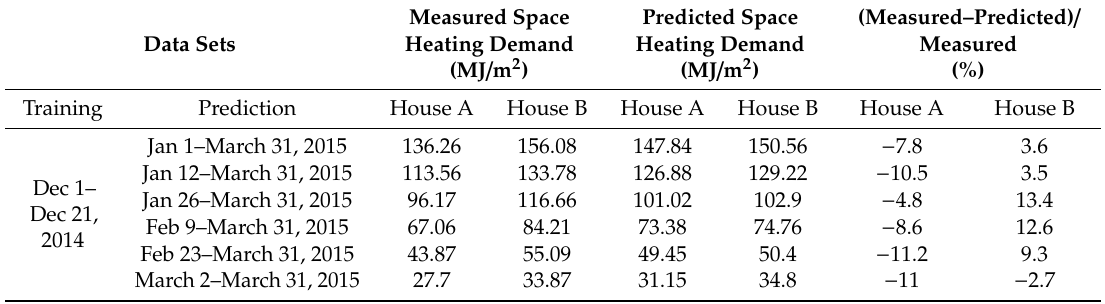
Table 7. Measured versus predicted total heating energy demand for houses A and B with the static window